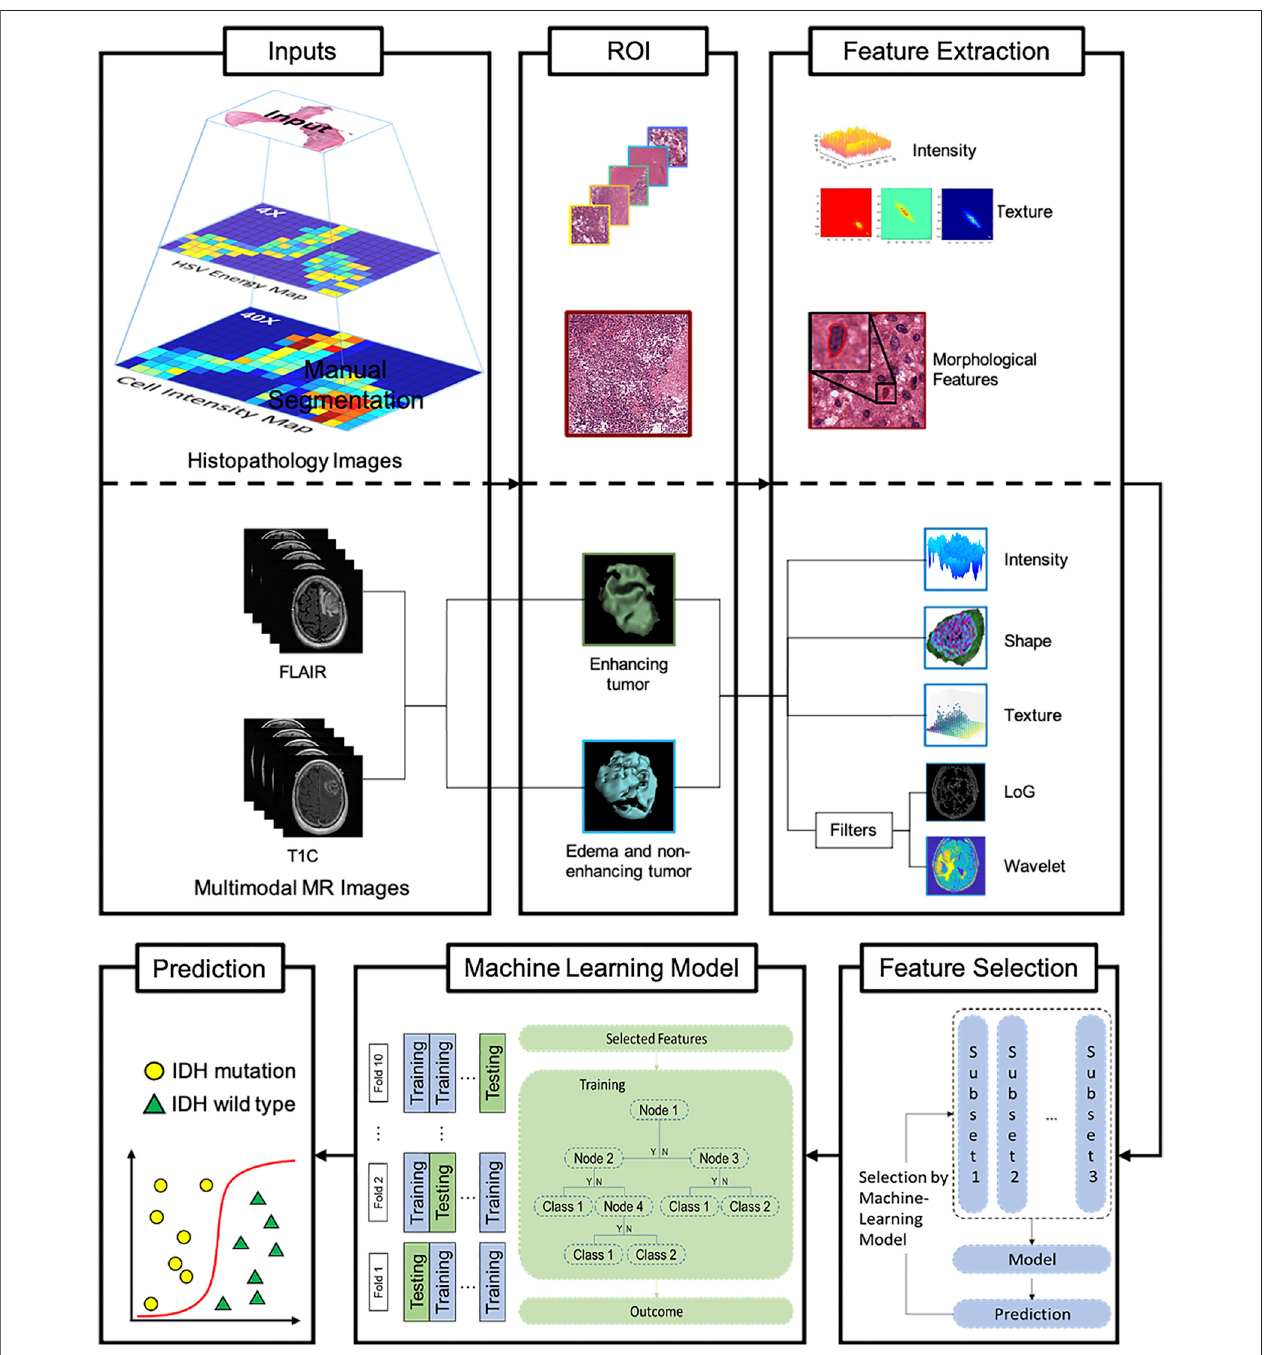
FIGURE 1 | Machine-learning framework for automated prediction of IDH glioblastoma genotypes. Histopathology and multimodal MR images are used as input (left column). Representative regions of interest (ROIs) are extracted (middle column) followed by histopathological and radiomics feature selection (right column). Subsequently, a Random Forest model-based Recursive Feature Elimination (RF-RFE)-algorithm is applied to select relevant while reducing redundant features. Following 10-fold cross-validation, the automated machine-learning model for glioma IDH genotype prediction is established. Abbreviations: GCLM, Grey Level Co-occurrence Matrix features; GLRLM, Grey Level Length Matrix features; GLSZM, Grey Level Size Zone Matrix features; NGTDM, Neighboring Gray Tone Difference Matrix features; GLDM, Grey level Dependence Matrix features, mass of features, which may have redundant information, then selected and processed to improve the predictive power of the machine-learning